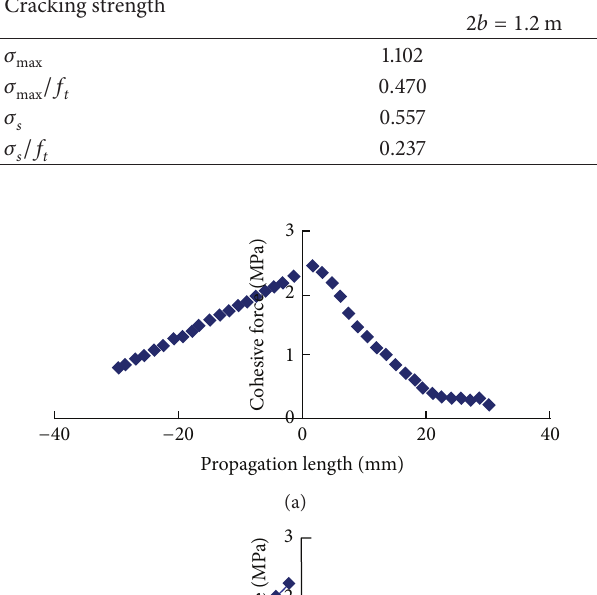
Figure 7: Local mesh of hyper-FEM for AIJs (number of